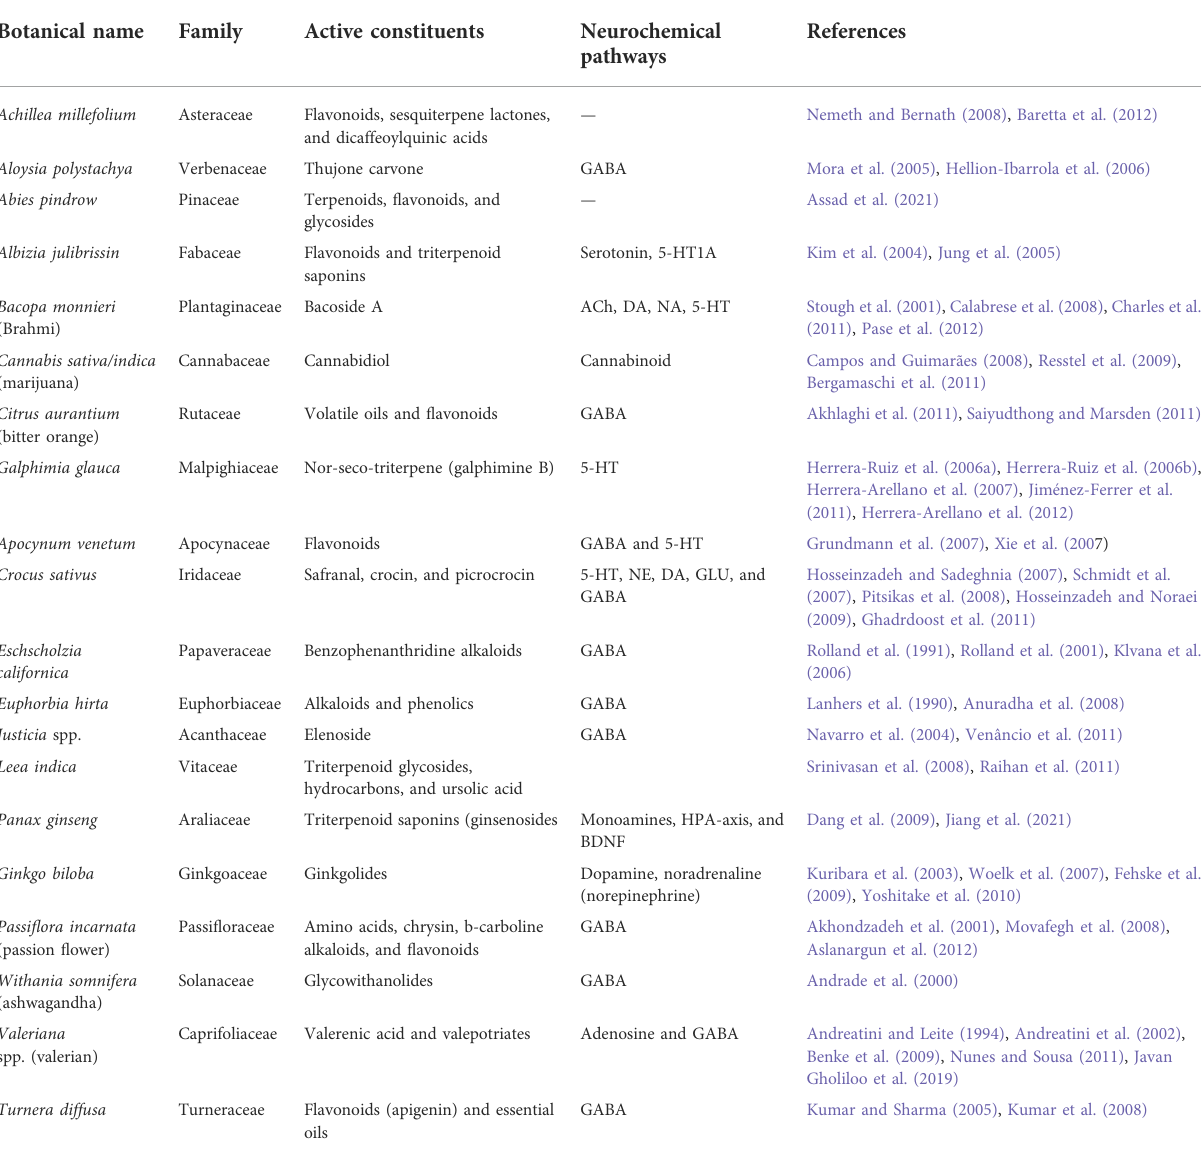
TABLE 3 Various plant species used for